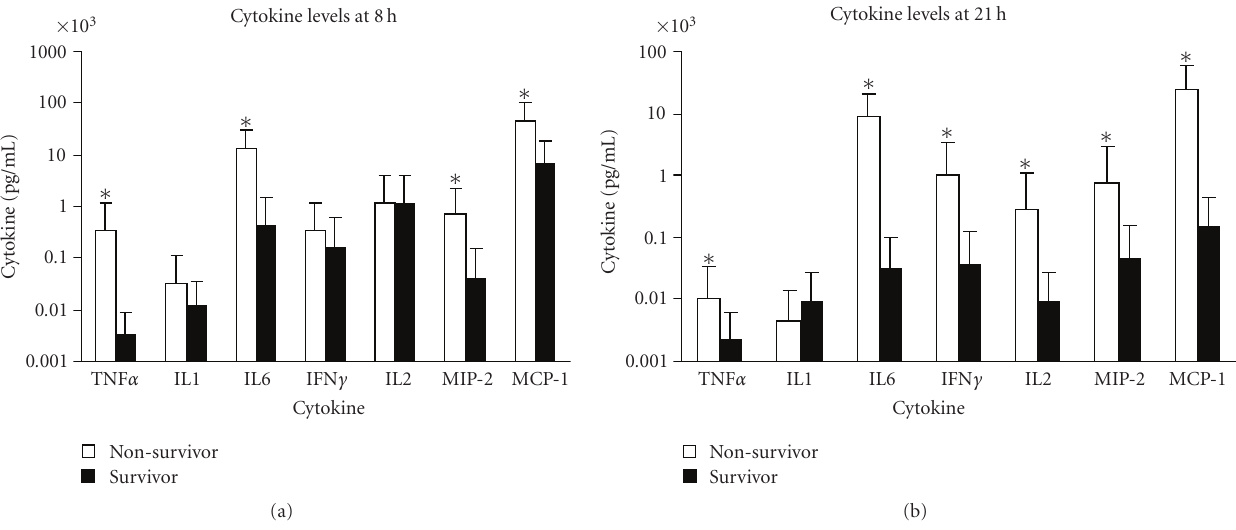
Figure 5: Serum levels of TNF α , IL-1, IL-6, IFN γ , IL-2, MIP-2, and MCP-1 of mice treated with SEB + LPS (a) 8 hours after SEB administration (b) 21 hours after SEB administration by survival status. Points represent the geometric mean ± standard deviation (SD) for survivors and nonsurvivors of mice treated with SEB + LPS. SEB + LPS group consisted of mice treated with 1 μ g SEB + 80 μ g LPS, 1 μ g SEB + 60 μ g LPS, 10 μ g SEB + 10 μ g LPS, 30 μ g SEB + 10 μ g LPS, 60 μ g SEB + 10 μ g LPS, 100 μ g SEB + 10 μ g LPS, 30 μ g SEB + 1 μ g LPS, and 100 μ g SEB + 1 μ g LPS. Values represent the geometric mean ± SD for each group. The “ ∗ ” indicates P < .05 when survivors were compared with nonsurvivors of toxic